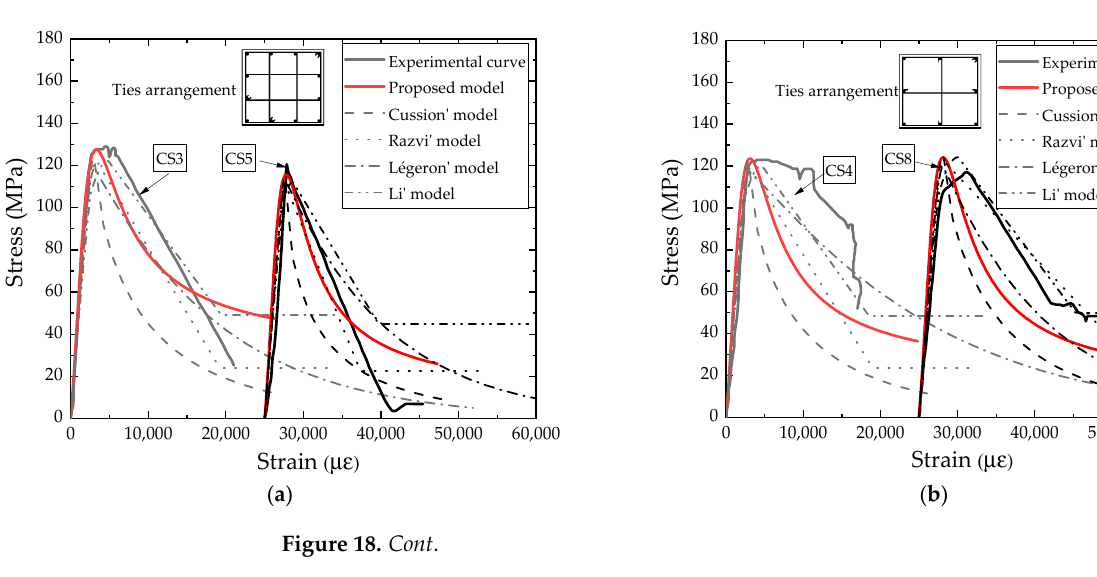
Figure 17. Comparison of experimental curves and analytical models (Nishiyama,1993): ( a ) 3, 4, and 7; ( b ) 8 and 10; ( c ) 11 and 12; ( d ) 13 and 14.